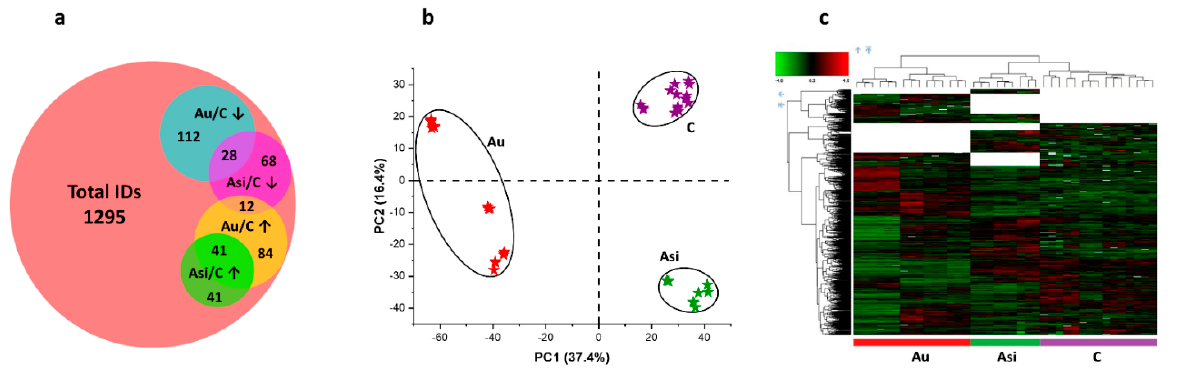
Figure 5. Mass spectrometry inference and relative quantification: ( a ) Venn intersection of total identifications (IDs) and the differentially abundant proteins in the Asi and Au groups, when normalized to the control values ( ↑ —up-regulated, ↓ —down-regulated); Representation of the quantitative profiles using Principal Component Analysis, ( b ) and Heat Map, ( c ) of the C (purple color), Asi (green color) and Au samples (red color). Both types of analysis demonstrate a clear distinction between the advanced hyperlipidemic proteomes (Au) as opposed to the PCSK9 siRNA-treated samples (Asi) and the control